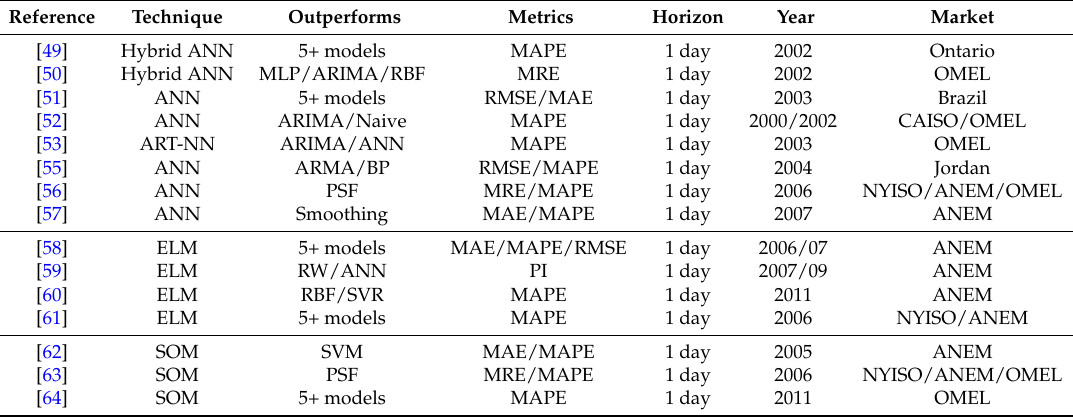
Table 2. Summary on ANN, self-organizing Kohonen’s maps (SOM) and extreme learning machine (ELM) for electricity